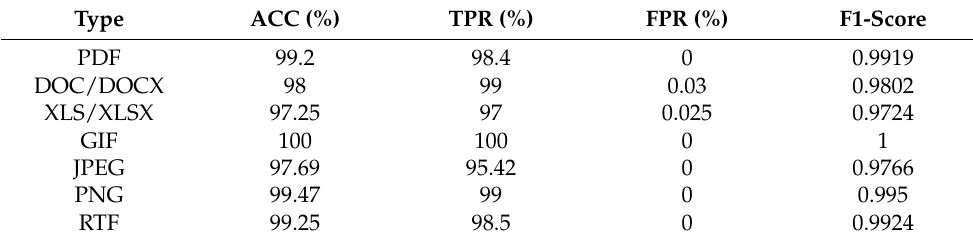
Table 8. The detection accuracies of different